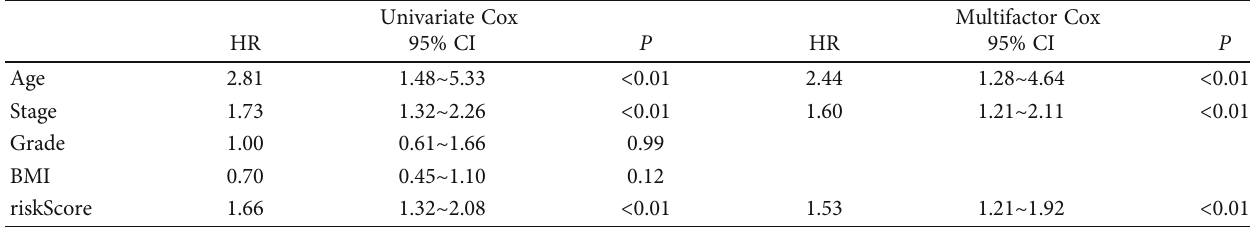
Table 2: Univariate and multivariate Cox regression analysis of clinically relevant